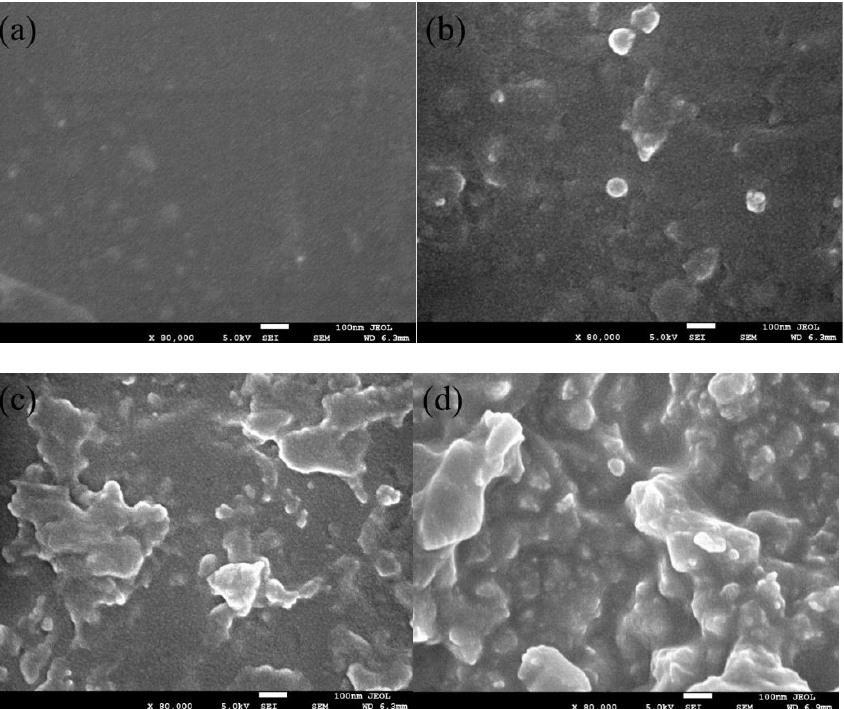
Figure 4. Surface morphology of nano SiO 2 particles modified coatings with different weight ratio ( a ) 0, ( b ) 0.5 wt%, ( c ) 1 wt%, and ( d ) 2 wt%.